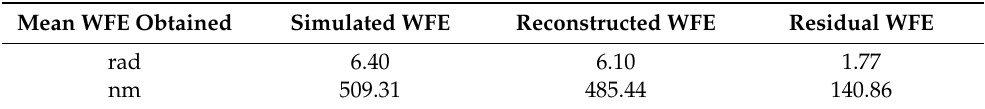
Table 1. Residual WFE obtained by the reconstructions made by the MLP in comparison with the original WFE for the first experiment.